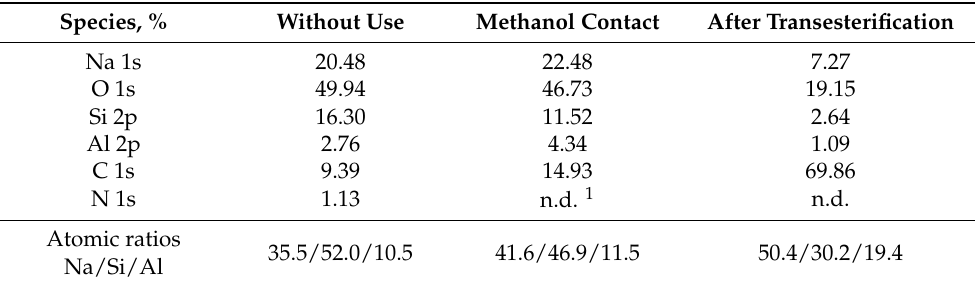
Table 5. Surface quantification and atomic ratios through XPS for NaNO 3 /SiAl 20/1 without any use, in contact with methanol and after a transesterification